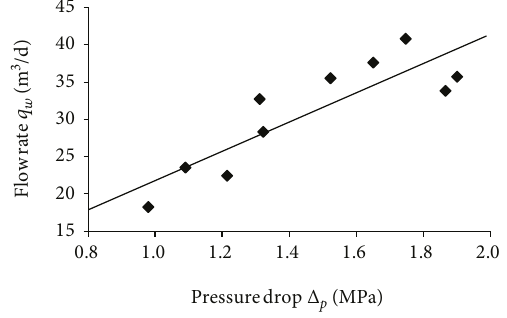
Figure 8: E ff ect of pressure drop on water production in two-phase producing